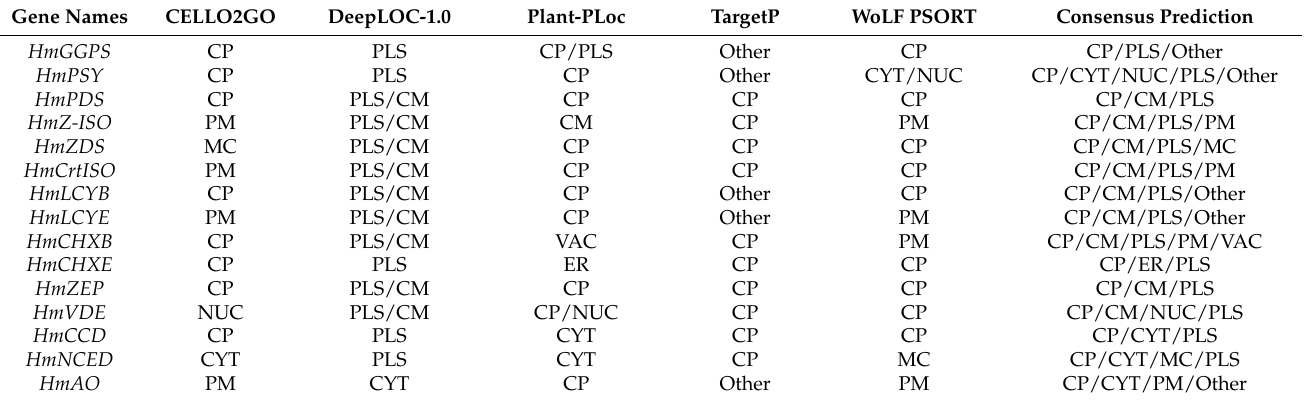
Figure 5. Tertiary structure of XP genes of H. moellendorffii . ( A ) HmCHXB , ( B ) HmCHXE , ( C ) HmZEP , and ( D ) HmVDE structures were created by using Chimera software (version 1.14) [62]. The amino (NH 2 ), carboxyl (COOH) termini, α -helices, and β -strands are shown in blue, red, green, and pink, respectively. Multiple alignments of each XP gene are shown in Figure S3. Table 1. The subcellular-localization predictions of H. moellendorffii CP, XP, and AP